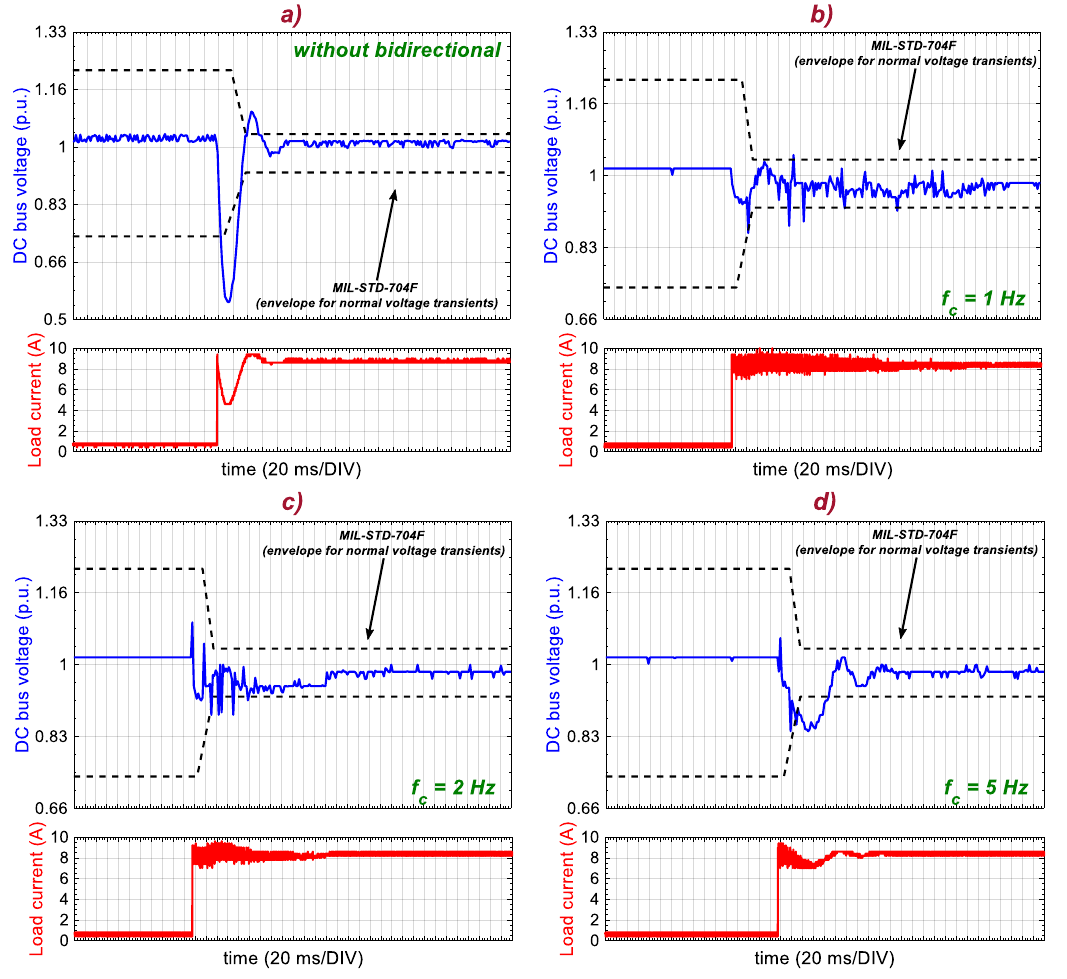
Figure 15. DC bus voltage response for a voltage sag, with the LPF cutoff frequency as a parameter, ( a ) without the proposed system; ( b ) f c = 1 Hz; ( c ) f c = 2 Hz; ( d ) f c = 5 Hz.